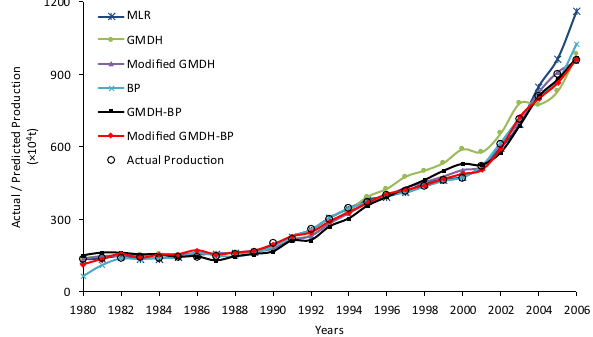
Fig. 3 Comparison chart for actual/predicted production by different